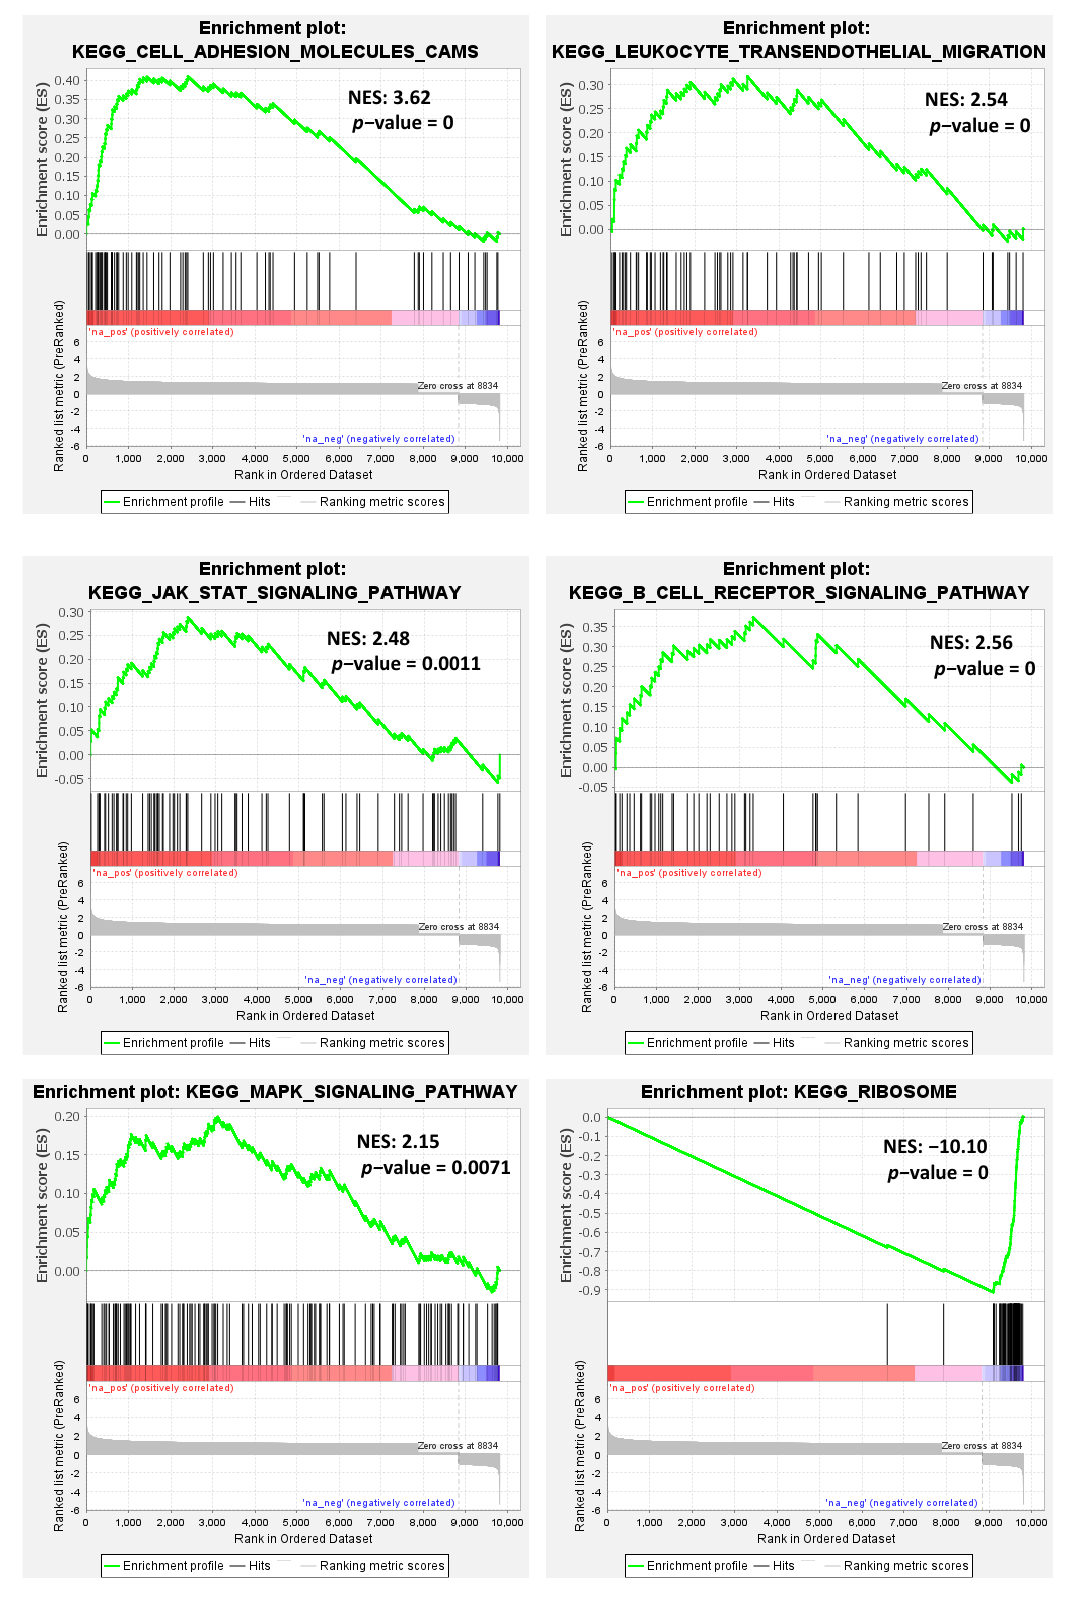
Figure 5. Enrichment plots of selected GSEA gene sets significantly modulated in MIAT IV versus I quartile. Normalized Enrichment Score (NES) and nominal p -value are reported for each plot.